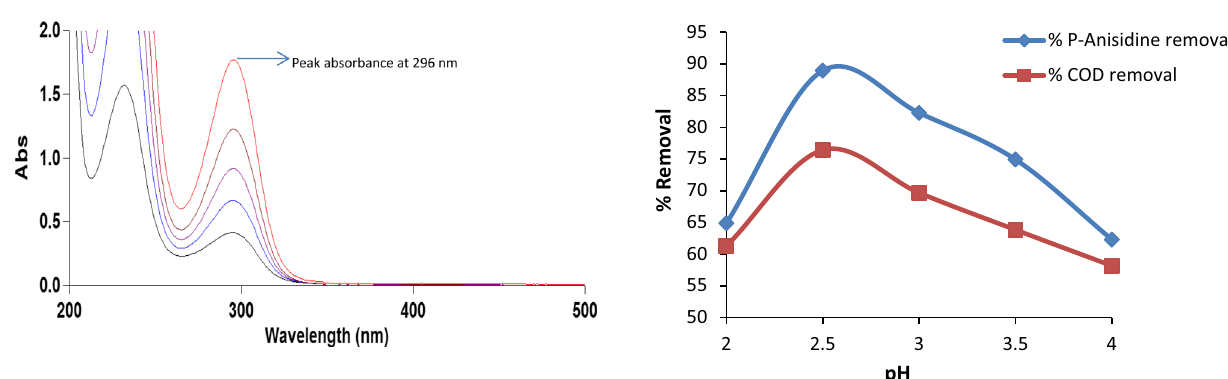
Fig. 1 Wavelength scan of p -anisidine. ( Source : UV–Vis spectropho- tometer)